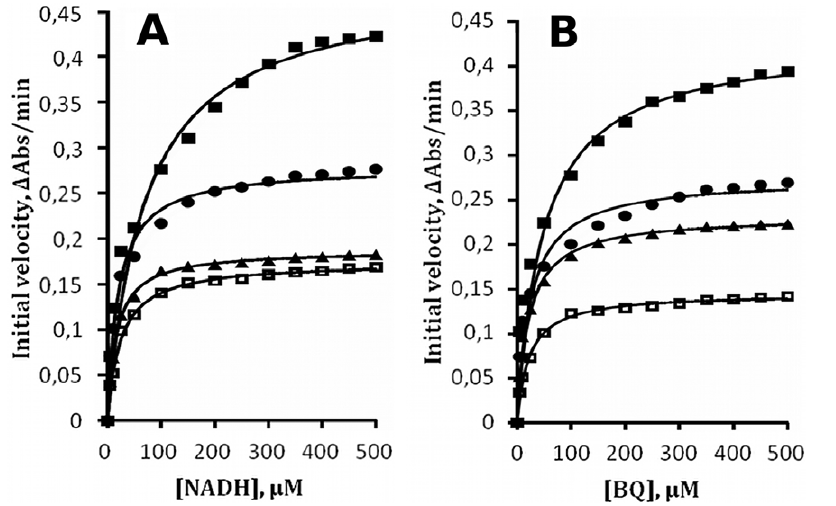
Figure 3. Ping-pong kinetics. Initial velocities were determined at 23 u C to limit the reaction to a single kinetic phase as much as possible. A. Titration of NADH at [BQ]=10 m M (open squares), 20 m M (triangles), 50 m M (circles), 100 m M (filled squares). B. Titration of BQ at [NADH]=10 m M (open squares), 20 m M (triangles), 50 m M(circles), 100 m M(filled squares). Solid lines represent non-linear least-squares best fit of the Michaelis-Menten equation to the data points. The values of apparent Km and apparent Vmax returned from the fit are given in Table